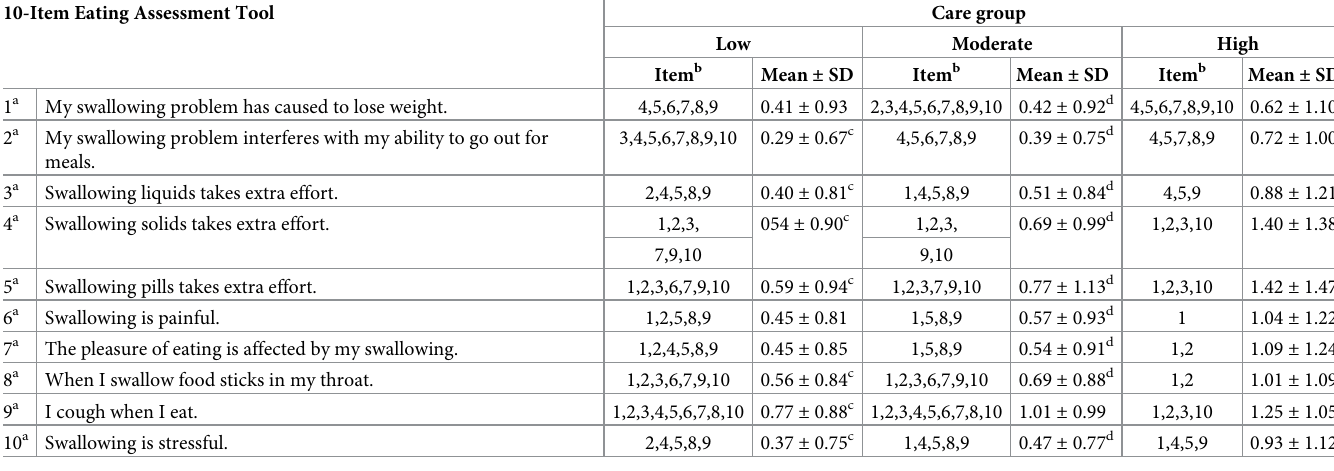
Table 7. Distribution of scores from three care groups of participants relating to each item of the Eating Assessment Tool